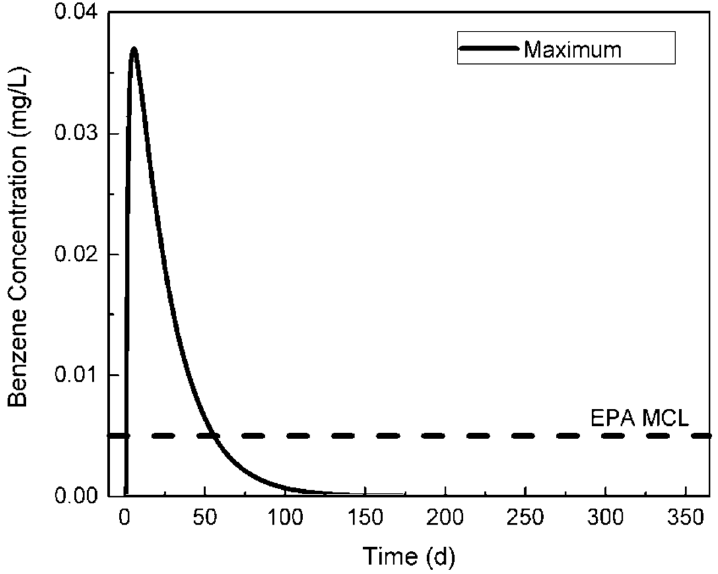
Figure 4. Concentration breakthrough curve for benzene predicted for a 10 ft groundwater table, accounting for degradation and sorption. The dashed line indicates the EPA MCL.